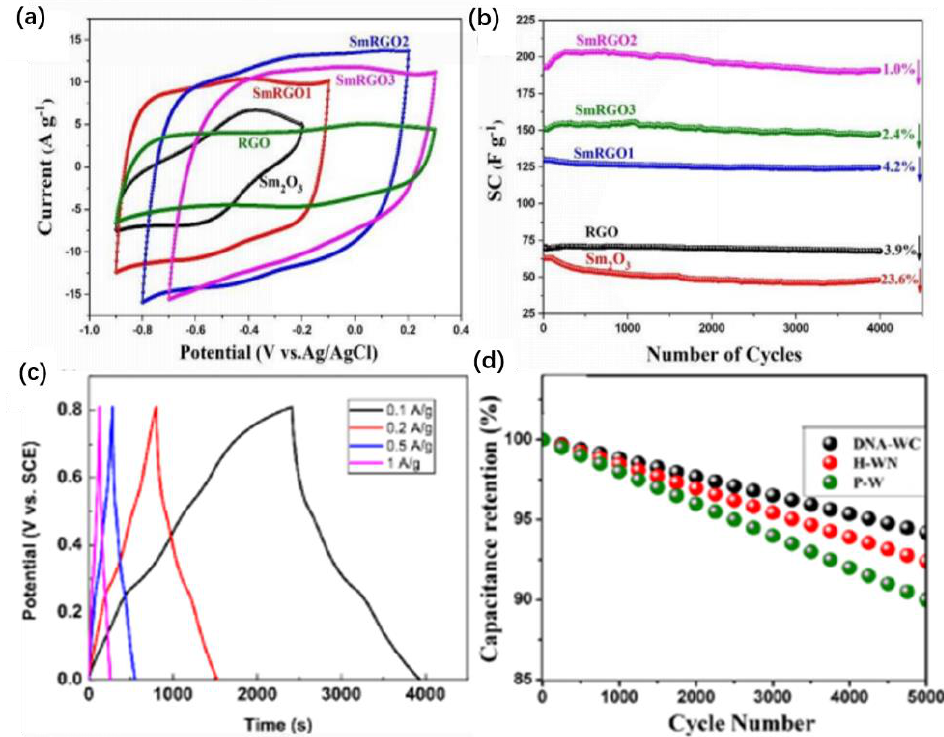
Figure 12. ( a ) Cyclic voltammograms of Sm 2 O 3 nanoparticles SmN and SmN – reduced graphene oxide (SmN-RGO) electrodes with various ratios at 50 mV/s. ( b ) Specific capacitances of the RGO, SmN, and different SmRGOs as functions of the number of cycles at 200 mV/s. Copyright © 2017 Elsevier B.V. ( c ) Galvanostatic charge – discharge (GCD) curves of a high-density hybrid Na 0.44 MnO 2 nanorod/active carbon films (HNAF) electrode. Copyright© 2021 Springer Nature Switzerland AG. ( d ) Overlay of cycling stability plots from GCD at a current density of 8 mA/cm 2 . Copyright © 2020 American Chemical Society.